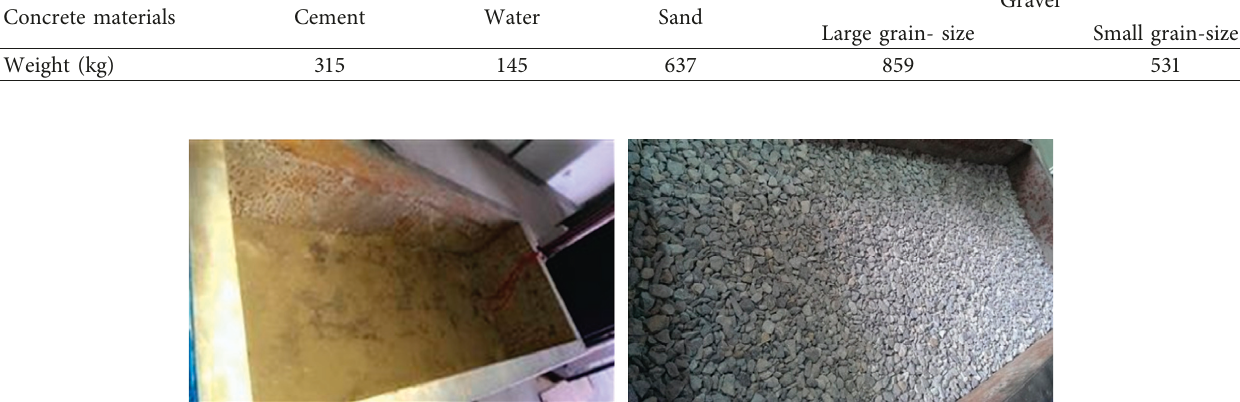
Figure 3: The ARSTS box preparation.